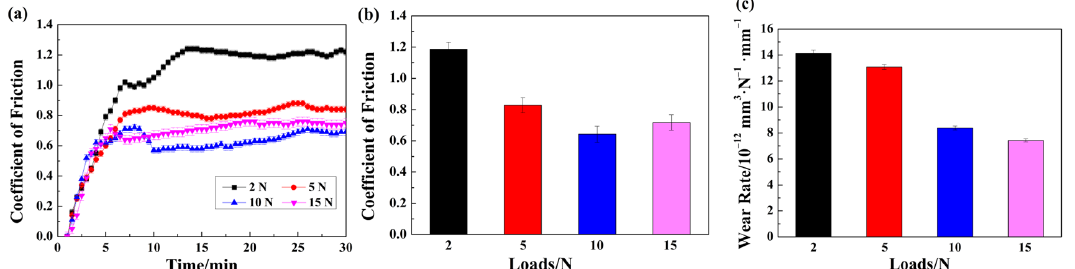
Figure 2. ( a ) Time dependent of CoF; ( b ) average CoF under different loads; ( c ) wear rate of AISI 52100 under different loads.